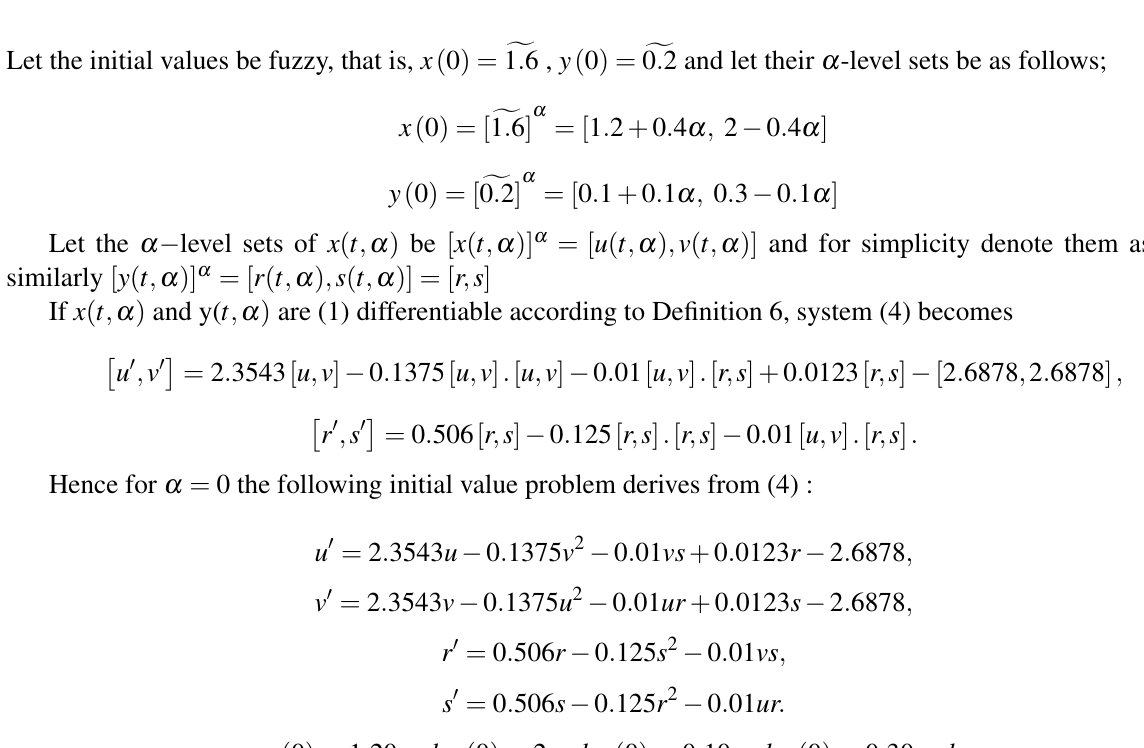
Fig. 1 Crips solution for